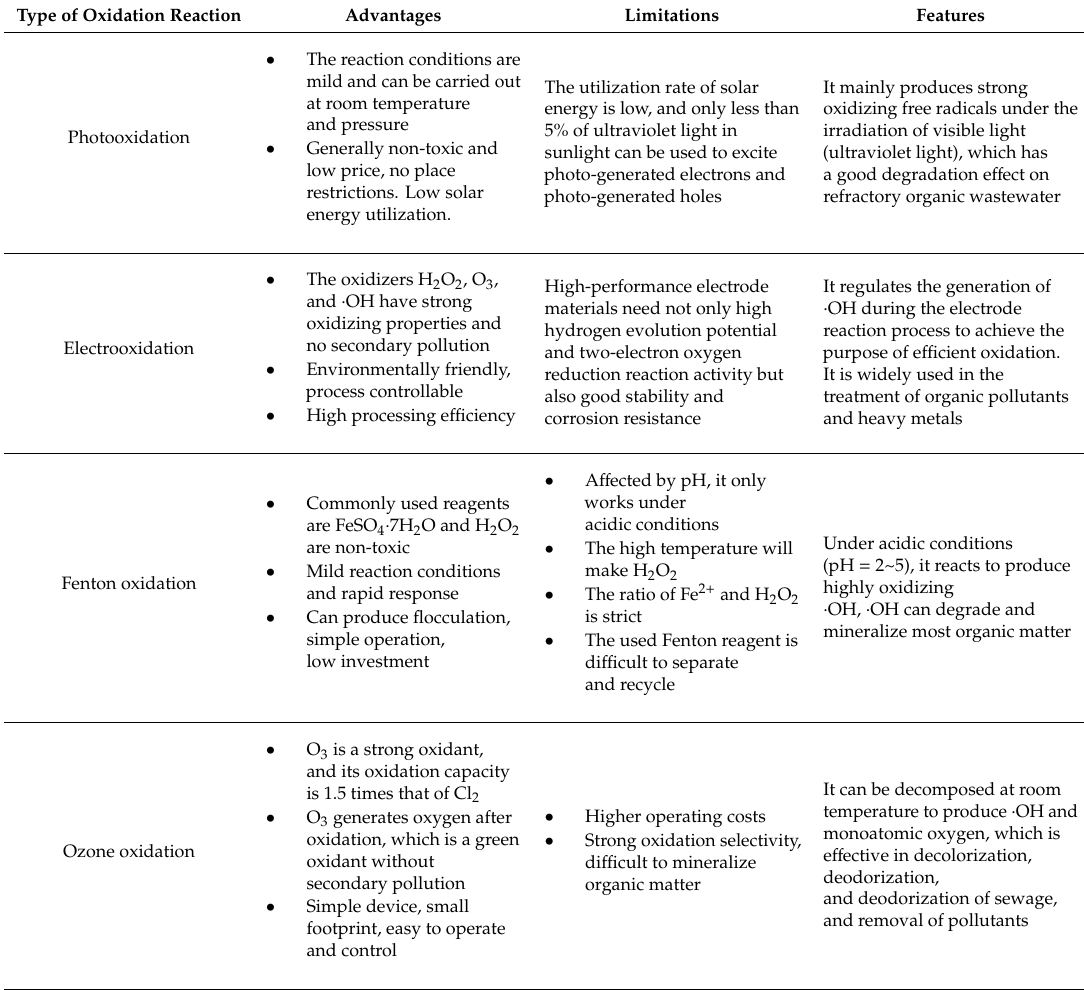
Table 5. The advantages, limitations, and characteristics of several basic advanced oxidation reactions. Type of Oxidation